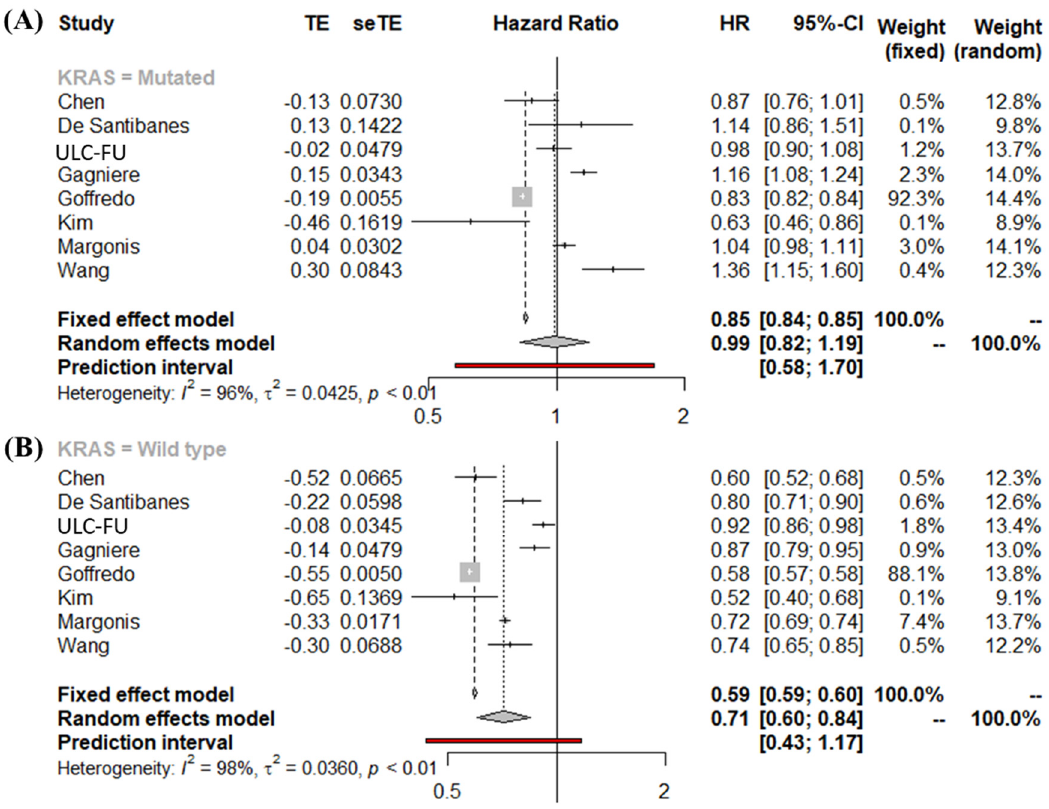
Figure 2. (A) Forest plot for right vs left (with rectum) in patients with KRAS-mutated tumors, (B) Forest plot for right vs left (with rectum) in patients with KRAS wild-type tumors; reference: right side.